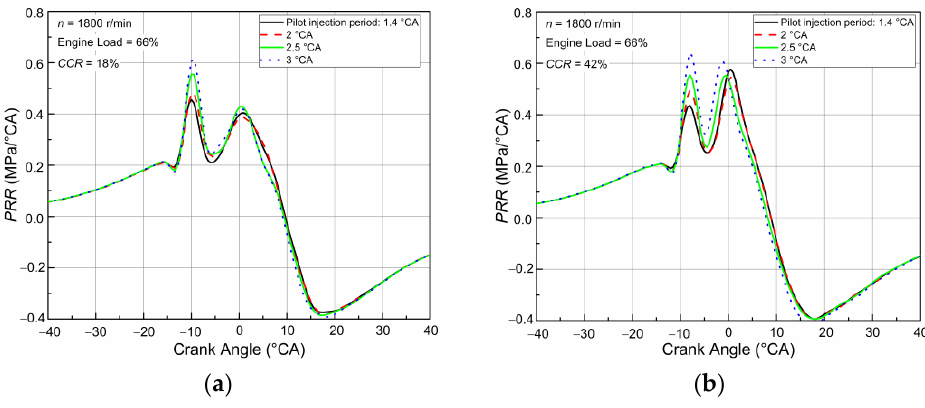
Figure 8. PRR under different pilot injection periods at 18% CCR ( a ) and 42% CCR ( b